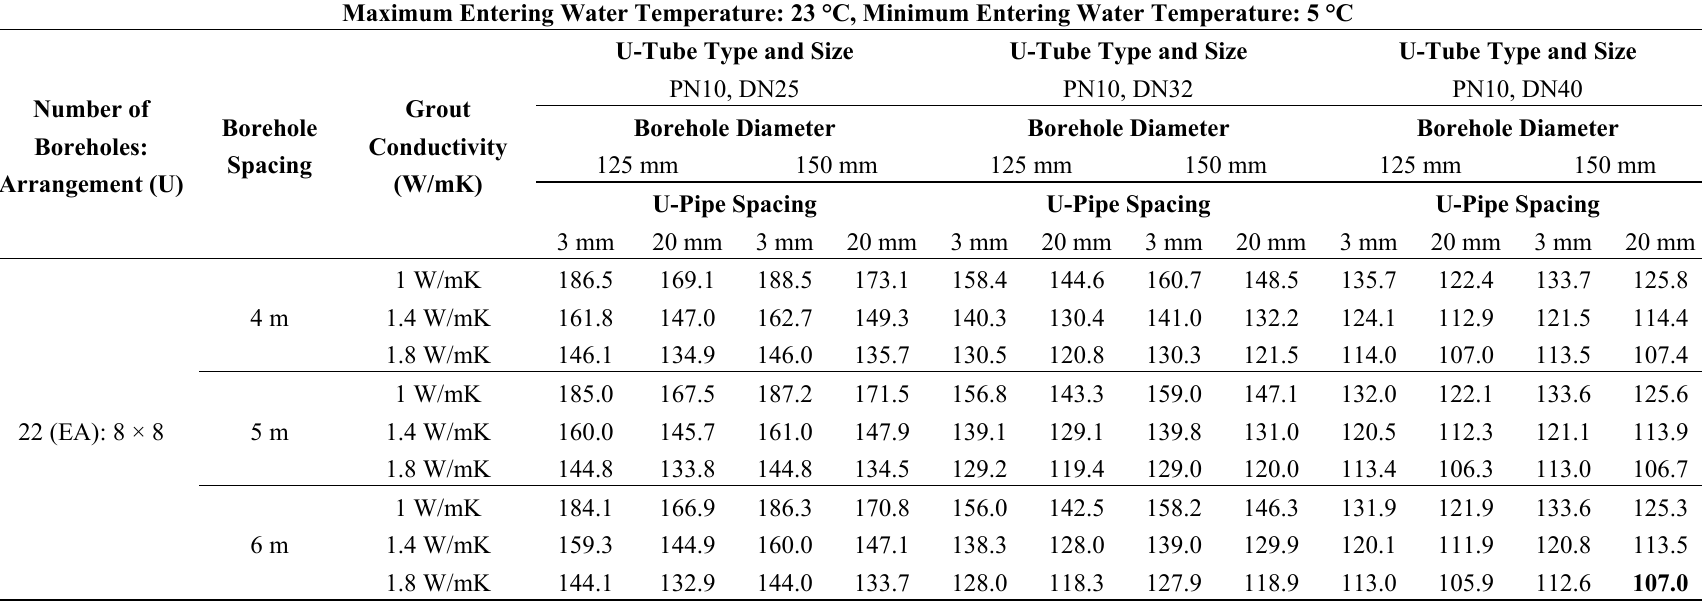
Table A2. Scenarios (length of borehole) of GHE considering EWT (27 °C) and characteristics of